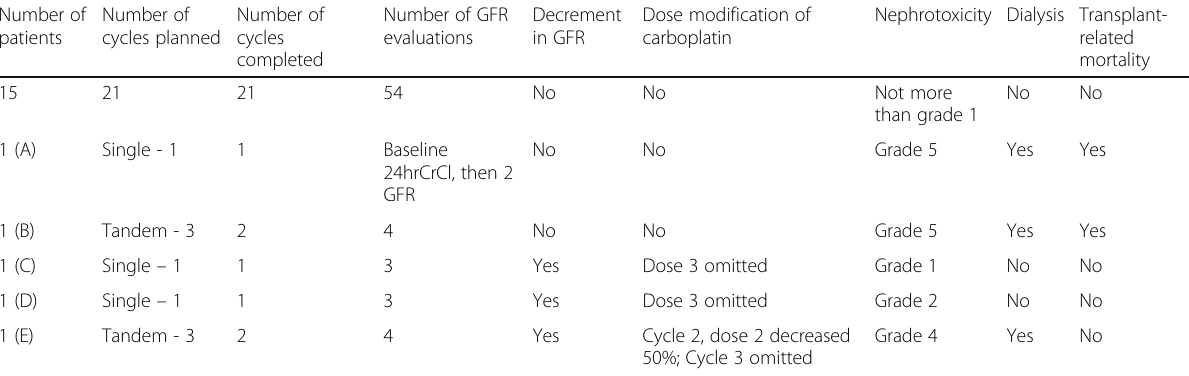
Table 3 GFR as an indicator for renal toxicity Number of Number of Number of patients cycles planned